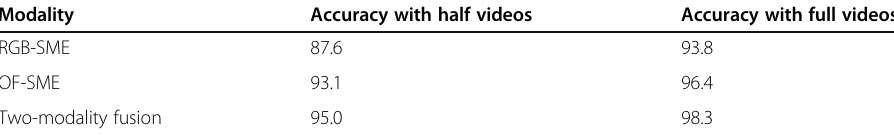
Table 1 Prediction accuracy comparison of different modalities on UT-Interaction set 1 (%) Modality Accuracy with half videos Accuracy with full videos RGB-SME 87.6 93.8 OF-SME 93.1 96.4 Two-modality fusion 95.0